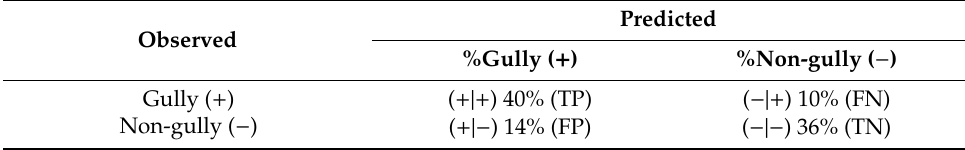
Table 6. Contingency matrix applied for assessment of the MARS